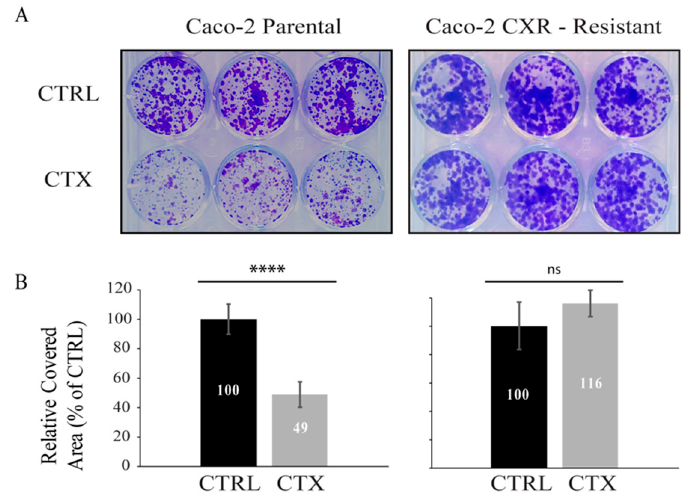
Figure 1. Colony forming assay of Caco-2 Parental and Caco-2 cetuximab resistant (CXR) clones. 2000 cells/well were plated with or without cetuximab (CTX) (10 µg/mL) for 10 days in DMEM medium supplemented with 10% fetal bovine serum, then cells were fixed, stained with Crystal Violet and quantified. Representative figures and quantification of the covered area by ImageJ are provided in A and B respectively. In ( A ) Caco-2 Parental cells (left) displayed 51% cell growth inhibition relative to CTRL, when treated with CTX whereas Caco-2 CXR–resistant cells (right) displayed undisturbed proliferation in the presence of CTX. ( B ) Quantification of relative covered area of Caco-2 Parental (left) and Caco-2 CXR–Resistant cells (right) in (A) by ImageJ is provided. The statistic was calculated by unpaired t-test, **** p < 0.0001, ns (not significant). This experiment was repeated more than three